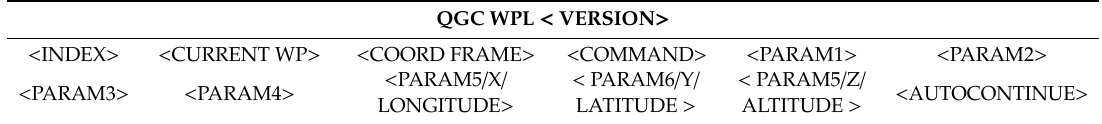
Table 1. Waypoint file format.